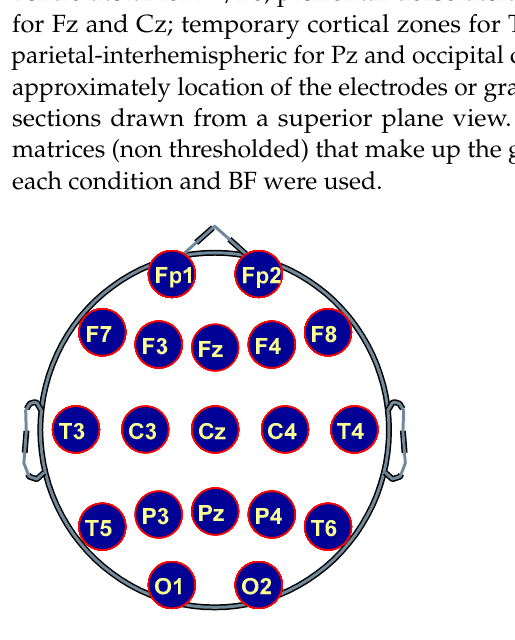
Figure 3. Superior plane of the EEG electrodes/graph nodes location.